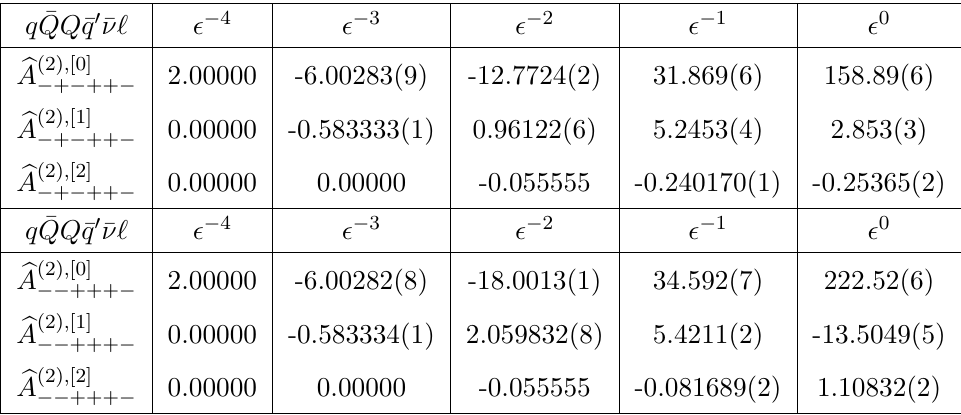
(cid:0) 1 q ; 2 (cid:22) ; 3 Q ; 4 (cid:22) q 0 ; 5 (cid:22) (cid:23) ; 6 ‘ Q